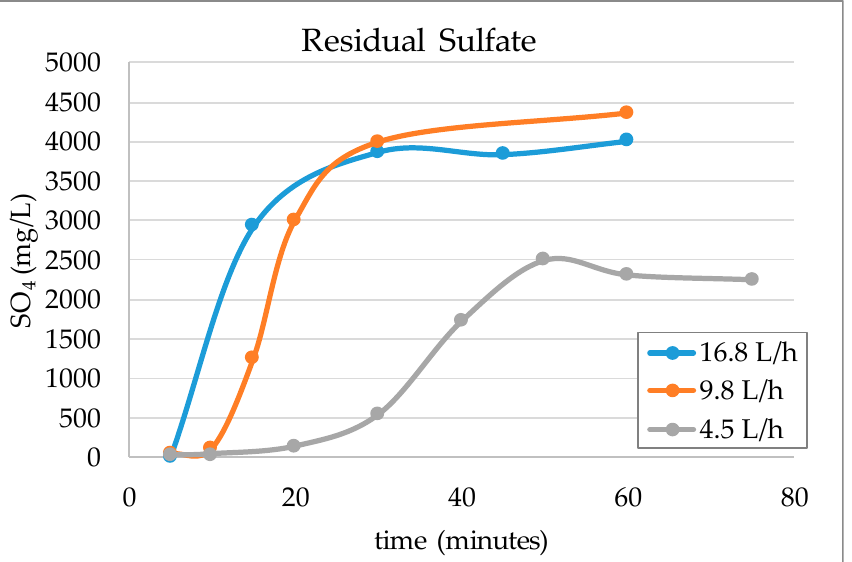
Figure 7. Effect of different water flowrates on adsorption. Figure 7. E ff ect of di ff erent water flowrates on